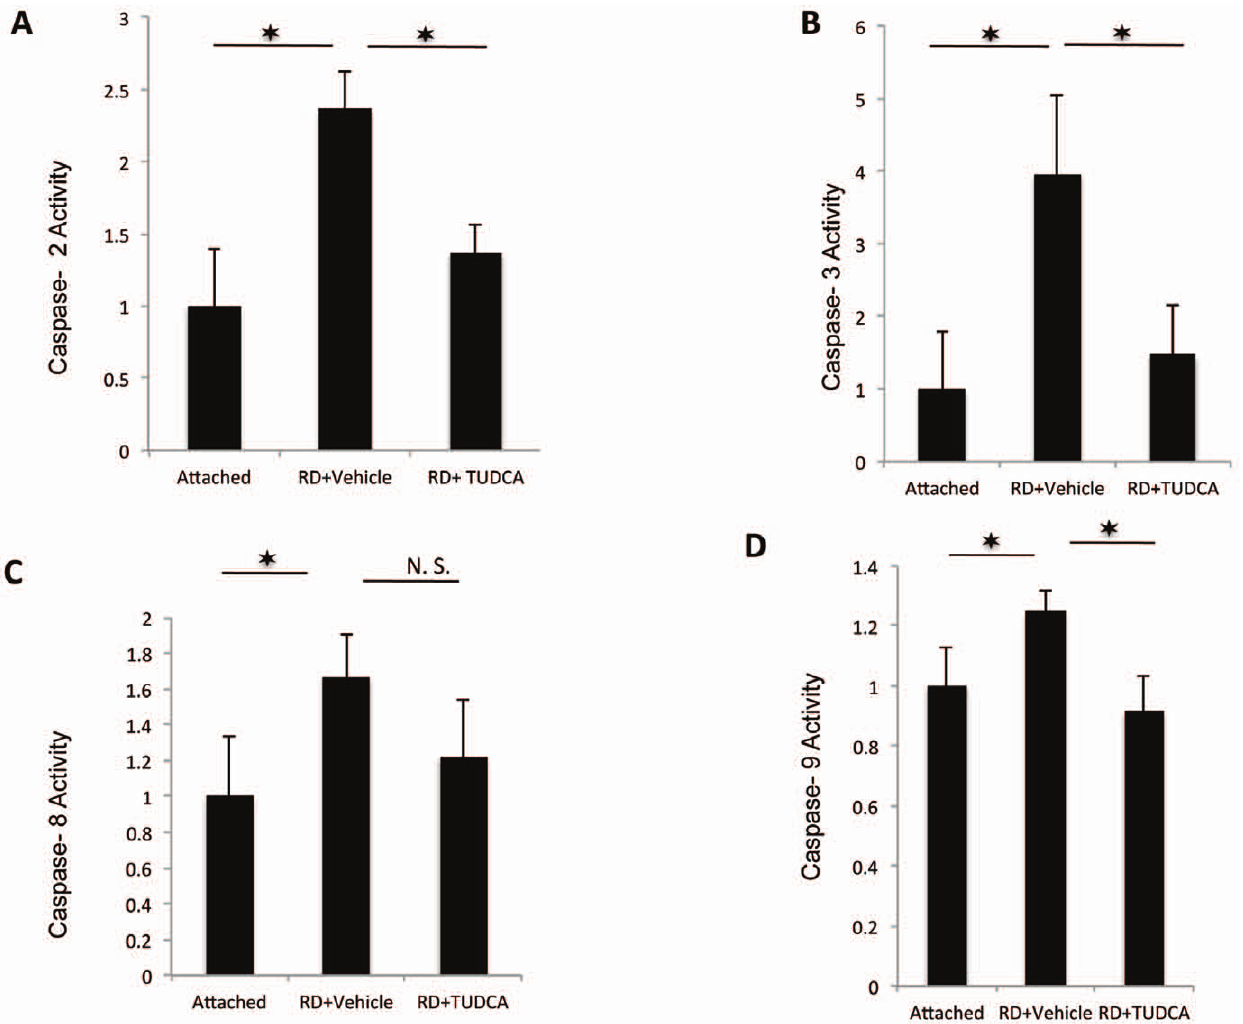
Figure 4. TUDCA’s effect on various caspases after RD. Assay of Caspases 2, 3, 8, and 9 activity after RD and TUDCA treatment. Treatment of RD with TUDCA decreased the activation of caspases 2, 3 and 9 (n=6, p , 0.05) but not of 8 (n=6, p . 0.05).